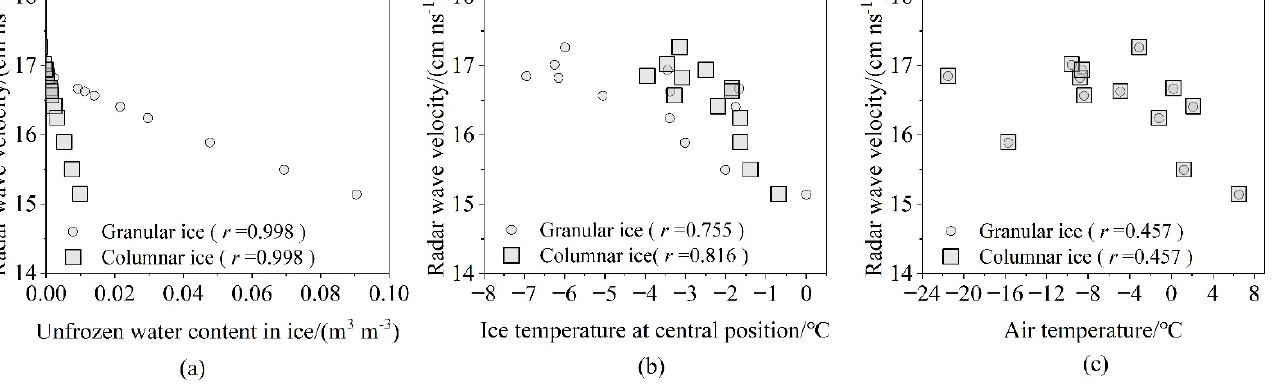
Figure 7. Scatter diagram of changes in radar wave velocity with ( a ) unfrozen water content in ice, ( b ) ice temperature at the central position of granular ice and columnar ice in ice layer, and ( c ) the air temperature at detection time of ice thickness.